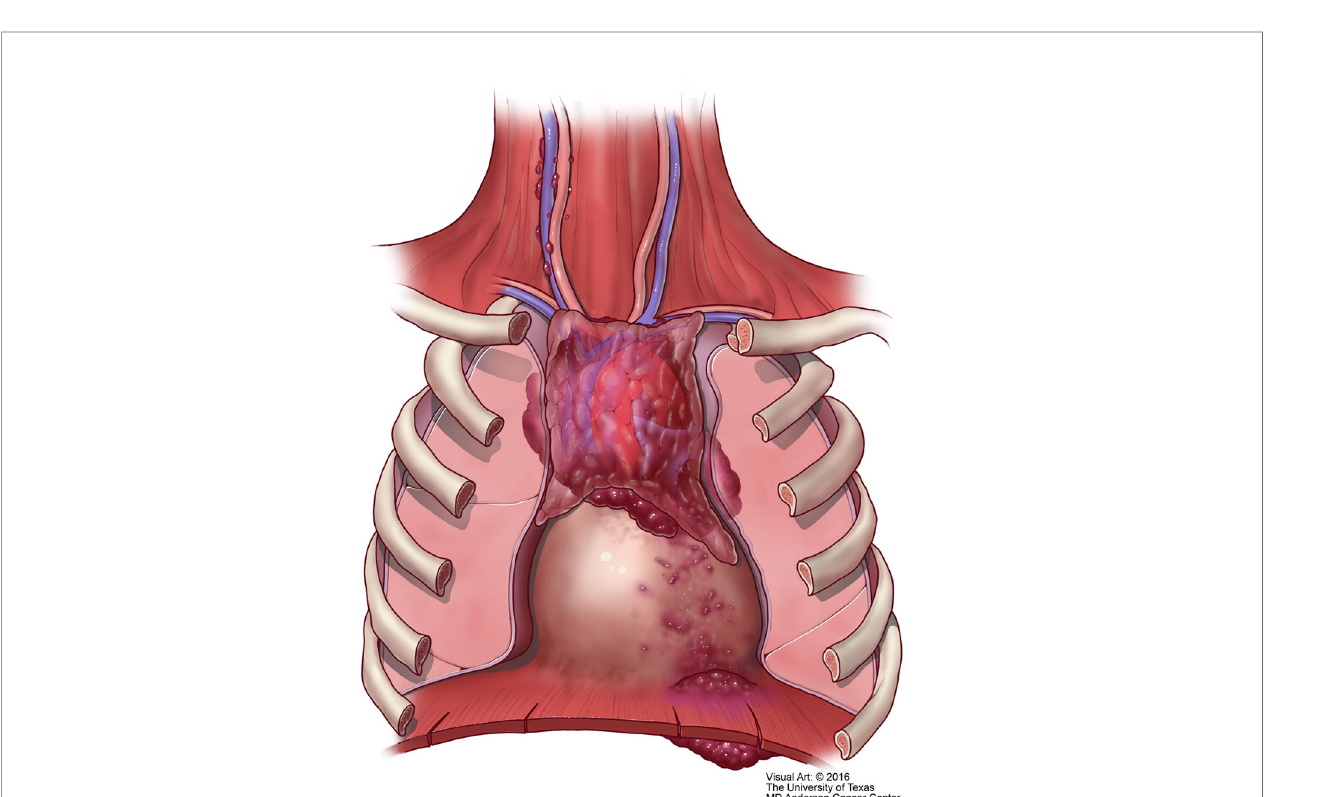
FIGURE 11 | M1 thymic carcinoma in which the tumor invades below the diaphragm or above the thoracic inlet (with permission from Dr. Moran Copyright © 2016).